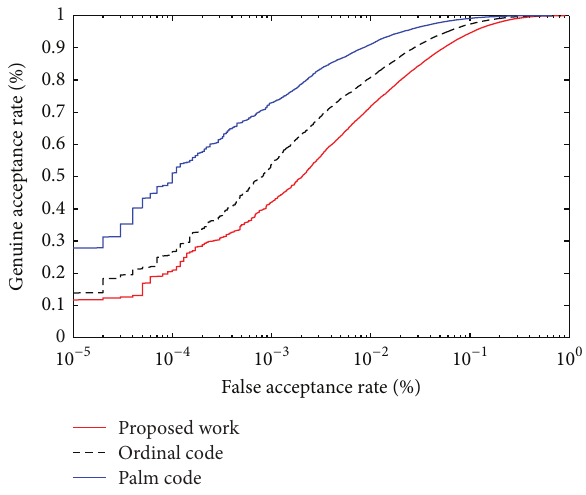
Figure 19: ROC curve using both local and global features of proposed DOST for IIT Delhi palmprint database.